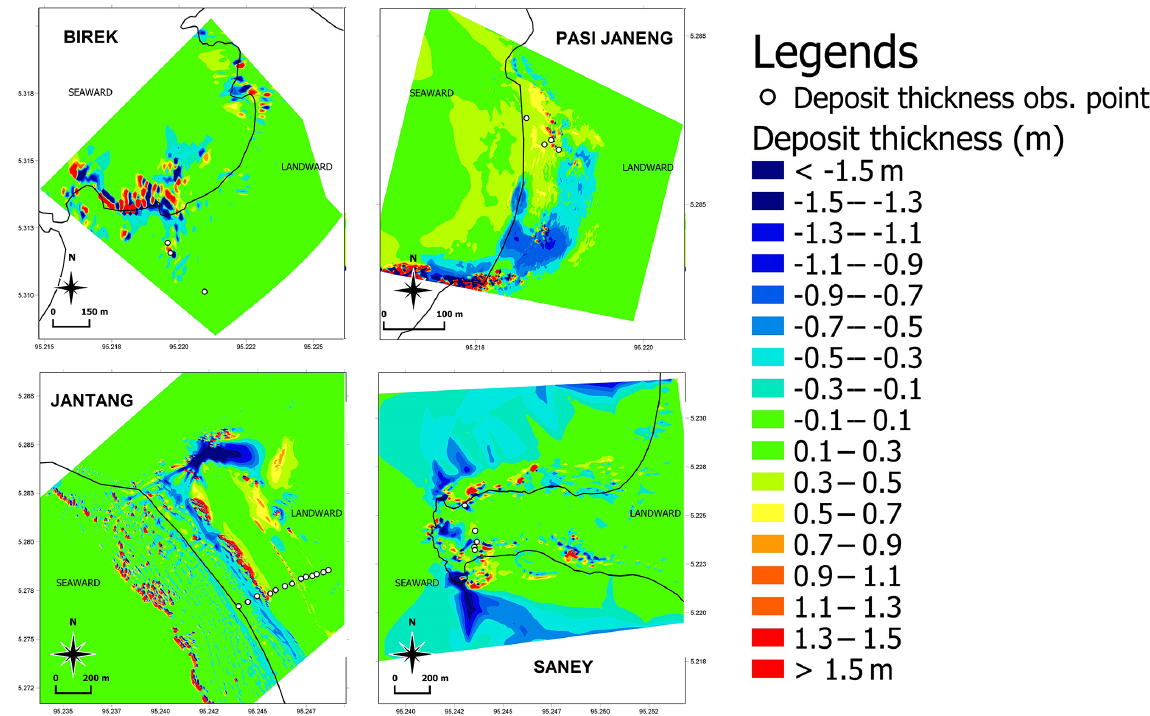
Figure 10. Tsunami deposit thickness from numerical models using Delft3D-FLOW at Birek, Pasie Janeng, Jantang, and Saney.